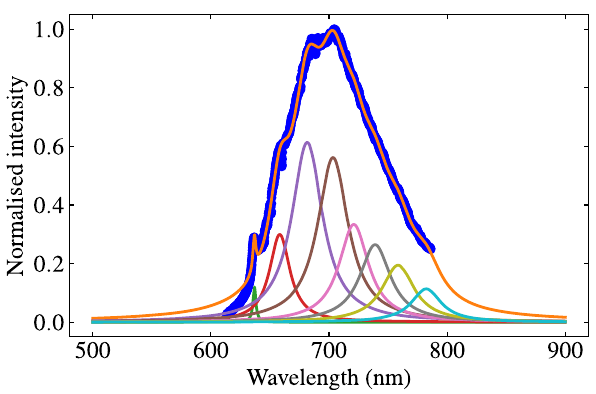
Figure 10: Spectrum of the nitrogen-vacancy (NV) centre from our sample by green wavelength pumping without any cavity mirrors.